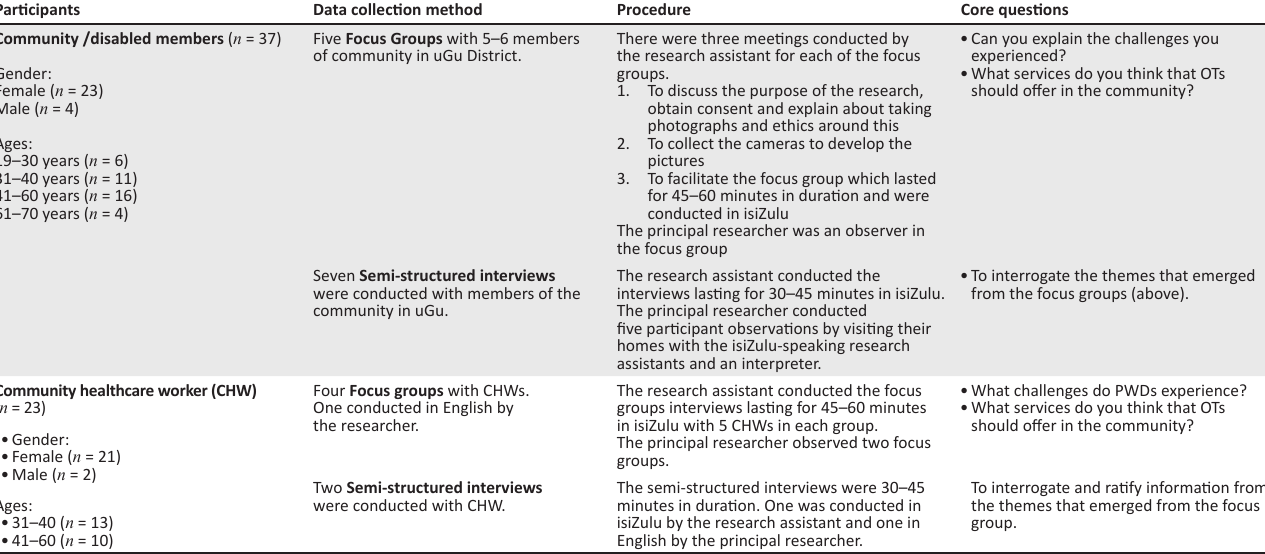
TABLE 1: Participant description and data collection methods.